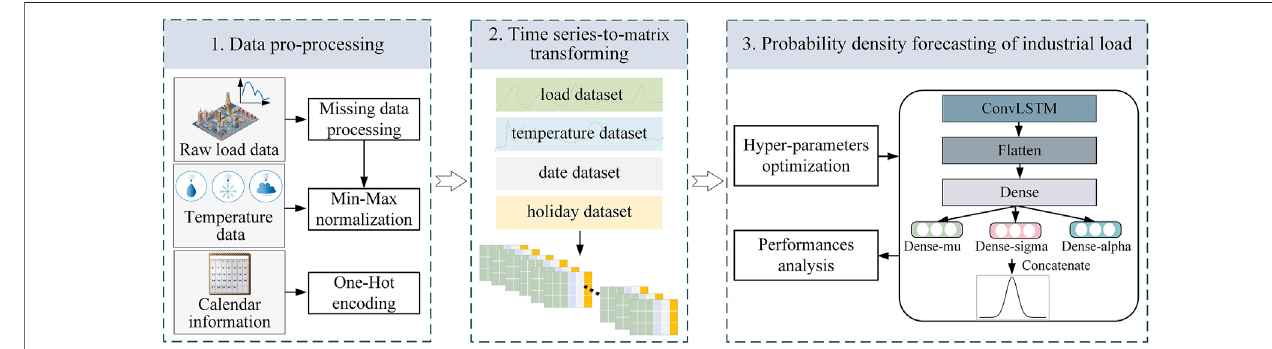
FIGURE 5 | Load forecasting framework based on the ConvLSTM-MDN model.